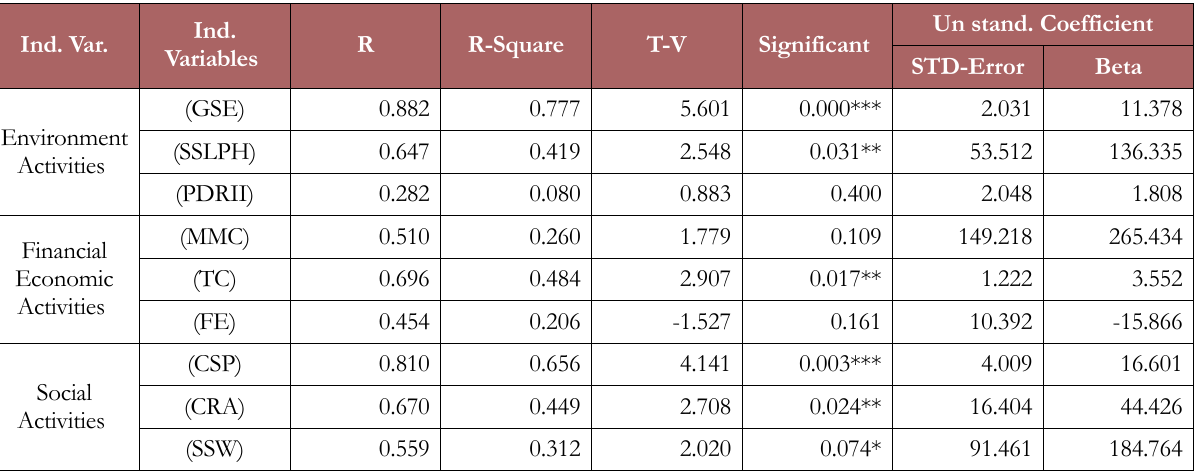
Table 3. Simple regression analysis of each green logistics activity and reserve money indicator as the monetary expansion